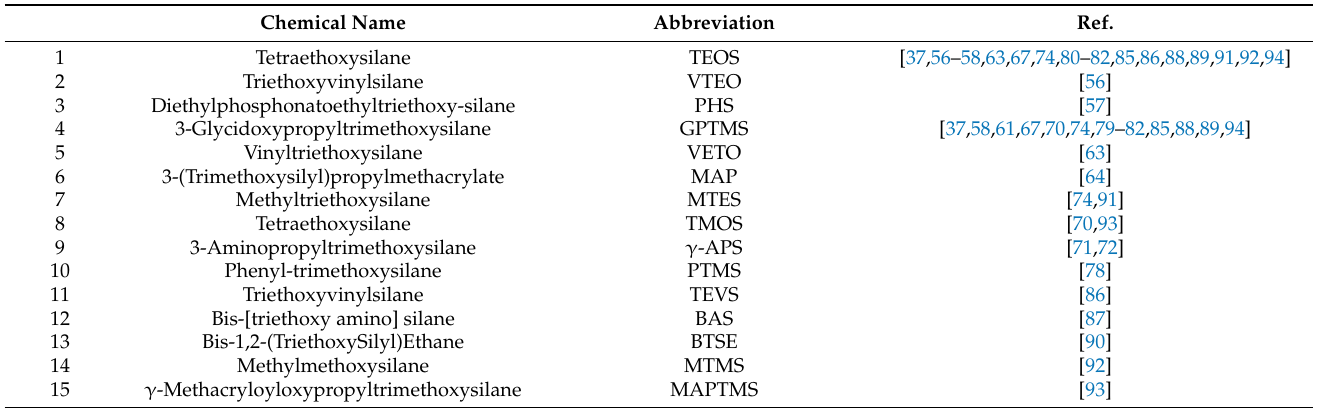
Table 1. The full names and abbreviations of the silane precursors used in the cited literature in Section